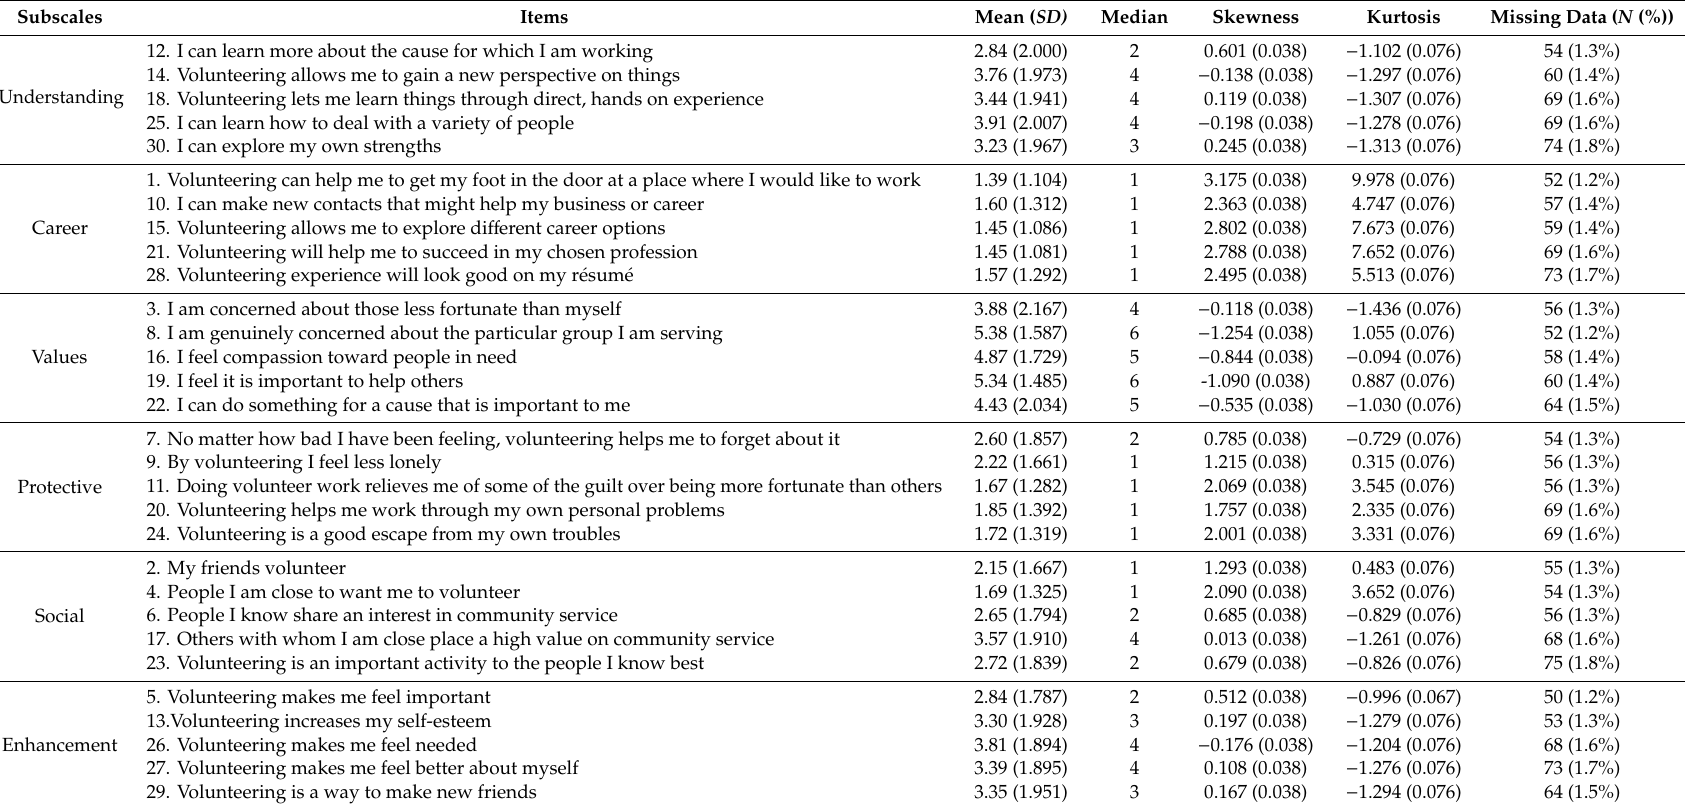
Table 2. Descriptive statistics for the Volunteer Functions Inventory (VFI)